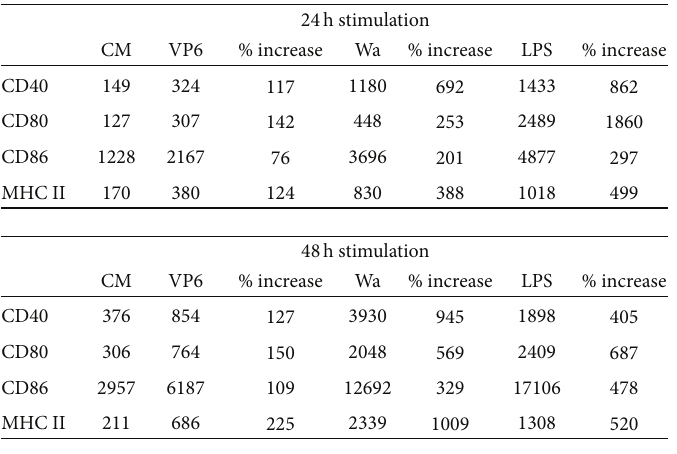
Figure 3: Effect of VP6 nanotubes on RAW 264.7 cell surface markers expression. The expression of CD40, CD80, CD86, and MHC class II (I-A/I-E) was analyzed by flow cytometry after 24 h and 48h incubation in the presence of 50 𝜇 g/mL VP6, 1: 10 diluted RV Wa, 1 𝜇 g/mL LPS, or culture media (CM) only. (a) Expression of the molecules on the cells in CM only and upregulation induced by VP6 and RV Wa are shown by overlaid histograms. The results are representative of three independent analyses done. (b) Table of mean fluorescence intensity (MFI) values obtained from the histograms in Figure 3(a) of each cell surface marker after treatment with VP6, RV Wa, LPS, or untreated